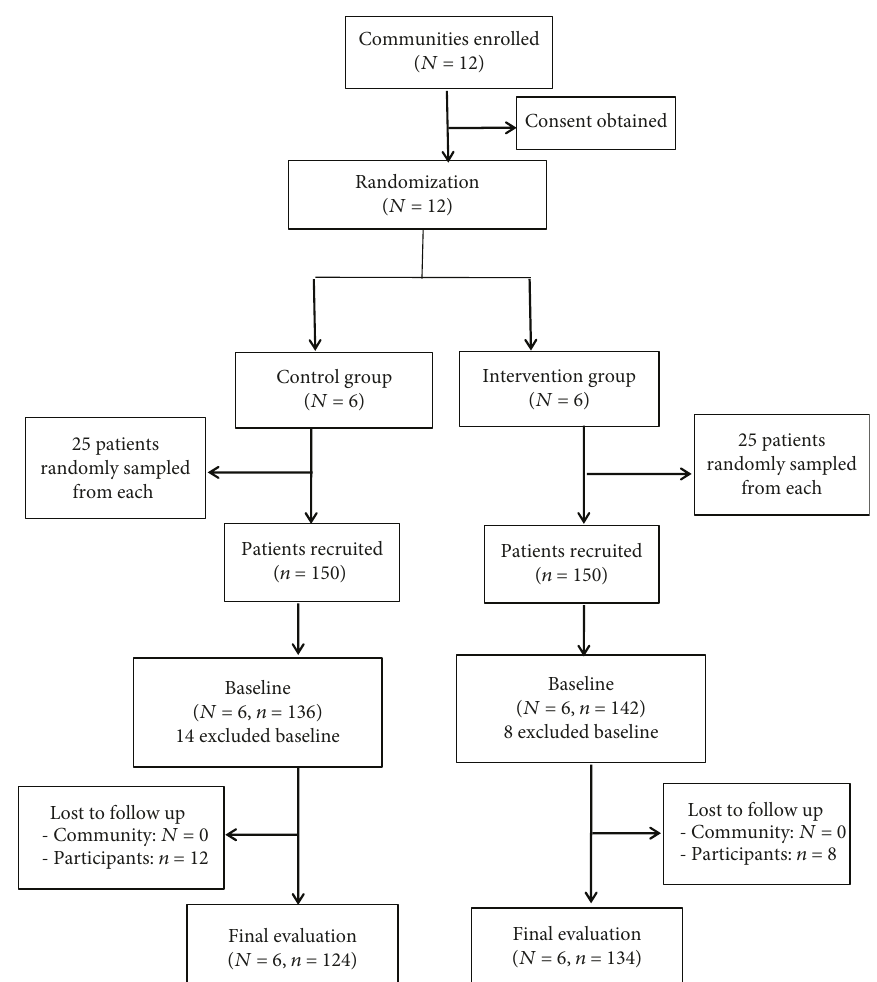
Figure 1: Flow diagram for participant recruitment from 12 communities in the Zhaohui Community Health Service Center for a 9-month group randomized experimental study in China,